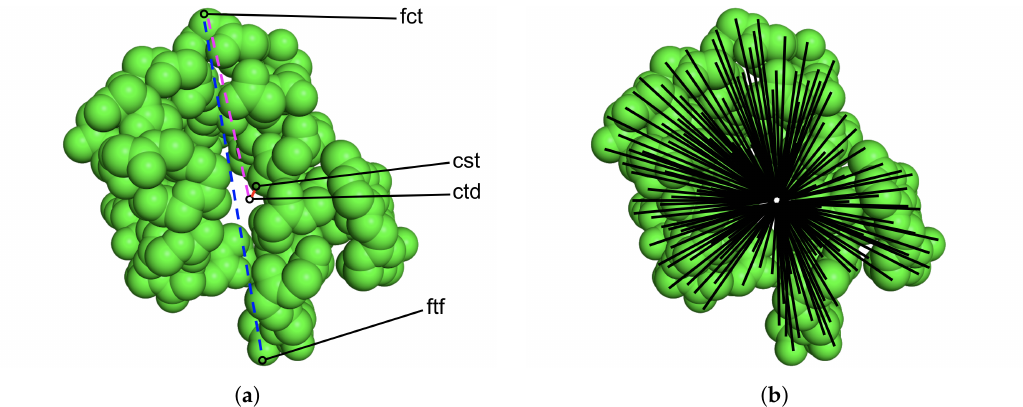
Figure 1. ( a ) The four reference points used to calculate USR metrics on a given tertiary structure are shown here. ( b ) Distances of all atoms from a chosen reference point, the ctd, are also